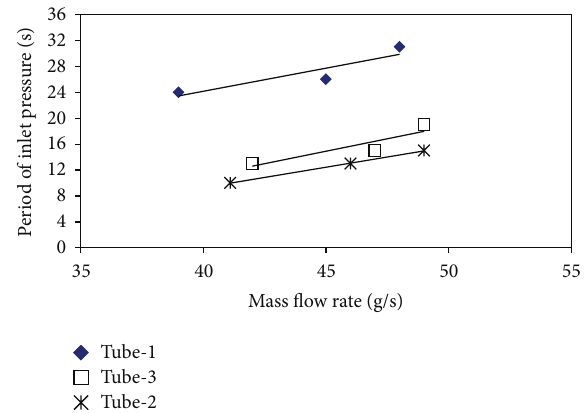
F 12: e variations in the period with the mass �ow rate for all tubes (p. d. o.).